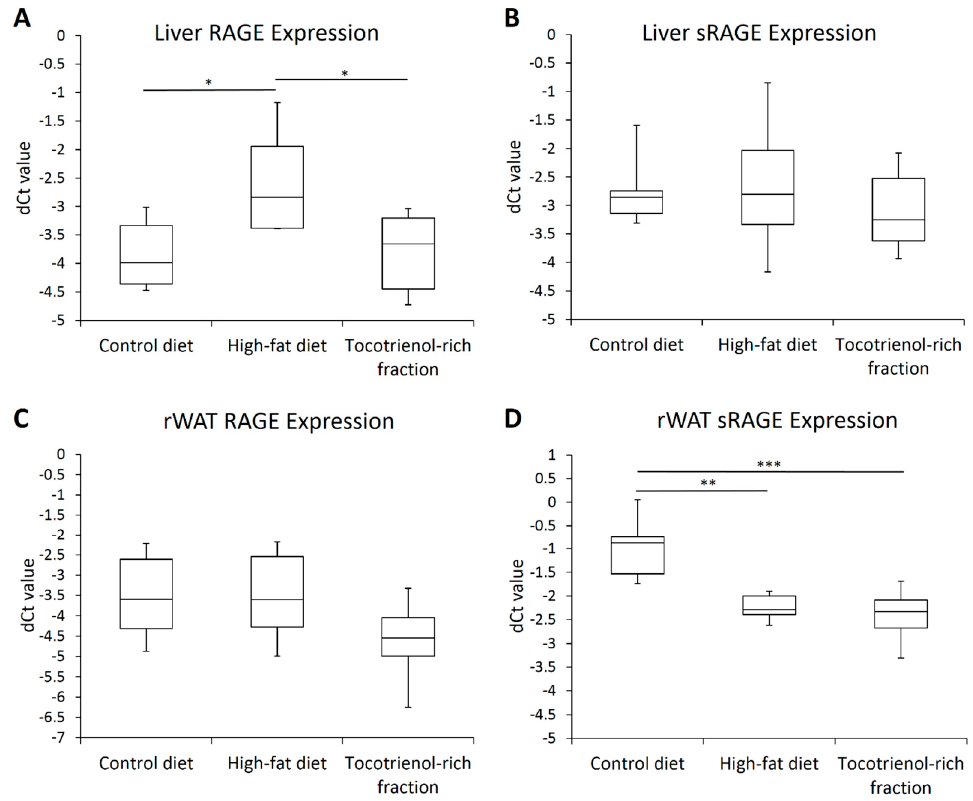
Figure 6. Box-and-whisker plots of normalized Ct values (dCt) of RAGE and sRAGE in the liver ( A , B ) as well as retroperitoneal adipose tissue ( C , D ) of the rats assigned to different treatment groups. Hypoxanthine phosphoribosyltransferase 1 (HPRT1), succinate dehydrogenase complex flavoprotein subunit A (SDHA), and β -actin (BAC) were used as the endogenous reference genes. Sample size was n = 7 per group. * indicates p < 0.05, ** indicates p < 0.01, and *** indicates p < 0.001 between groups. RAGE: receptor for advanced glycation end product; sRAGE: soluble receptor for glycation end product; rWAT: retroperitoneal white adipose tissue.